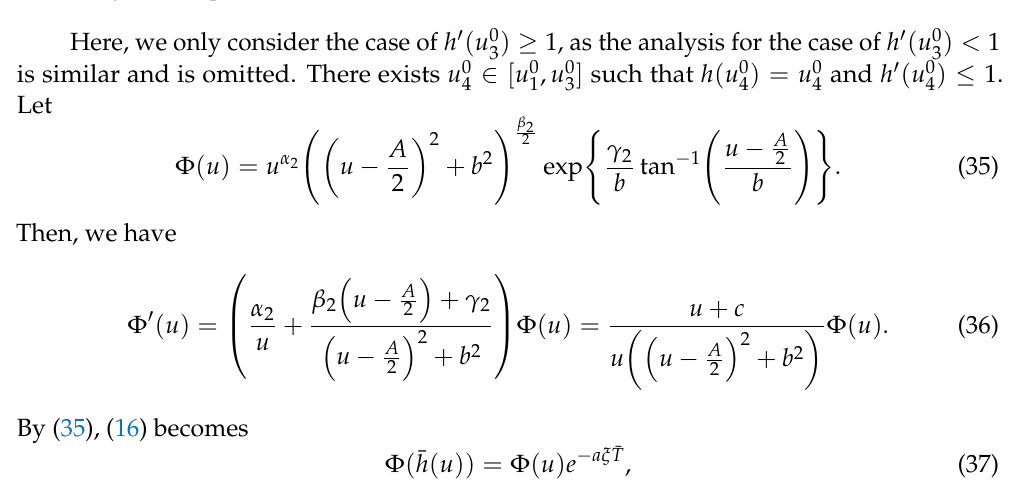
Figure 5. Set g ∗ < c < c ∗ . Panels ( A – D ) present four possible situations when the model (3) and (4) has exactly three T -periodic